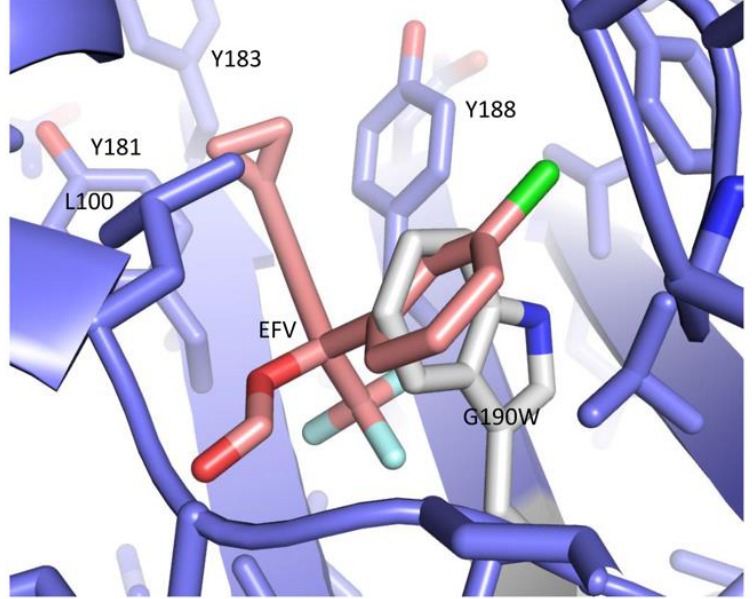
Figure 15. Accommodation of the G190W mutation by the NNRTI site. Ribbon diagram of the RT–EFV complex (PDB ID: 1FK9, [32]) containing a G190W mutation modeled using Pymol (DeLano Scientific, Palo Alto, CA, USA). The NNRTI site in the p66 E structure is in principle able to accommodate the large Trp190 side chain in the same region that accommodates EFV. Introduction of the same mutation into the compact p51 structure results is substantial steric conflicts (not shown). The p66 palm domain is shown in blue, EFV is beige, and the mutated G190W residue is gray. Since the NNRTI site is present only in the extended ( E ) conformation, the G190W mutation increases the E/C ratio, promoting dimer formation as illustrated in Figure 14.